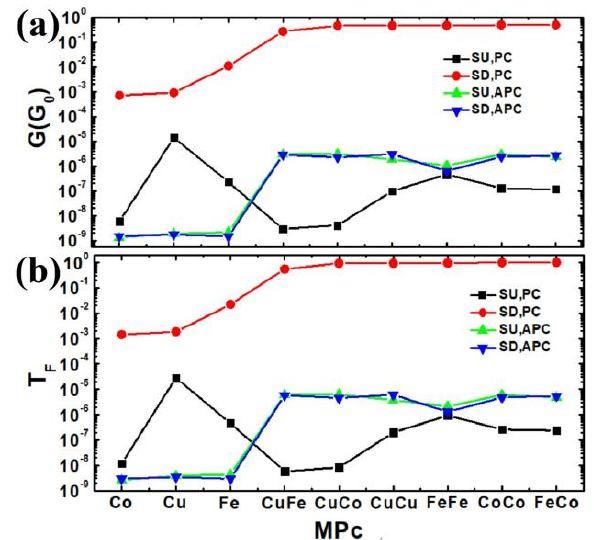
Figure 2. The conductance G ( a ) and transmission at the Fermi level ( b ) of the MPc molecular device for monolayer CoPc, CuPc, FePc, bilayer CuPc-FePc, CuPc-CoPc, CuPc-CuPc, FePc-FePc, CoPc-CoPc, and FePc-CoPc at zero bias.